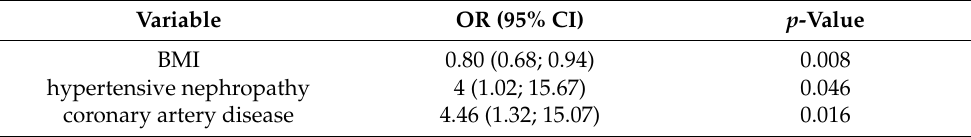
Table 4. Multivariate regression analysis to predict an ICU admission during the hospital